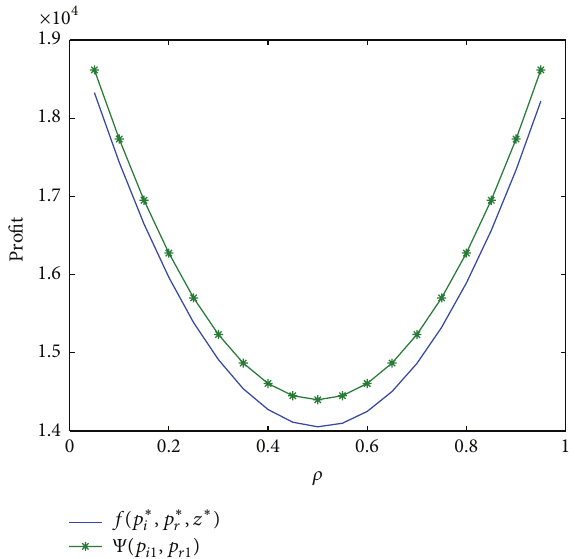
Figure 2: Impact of 𝜌 on the profits under demand certainty and uncertainty.